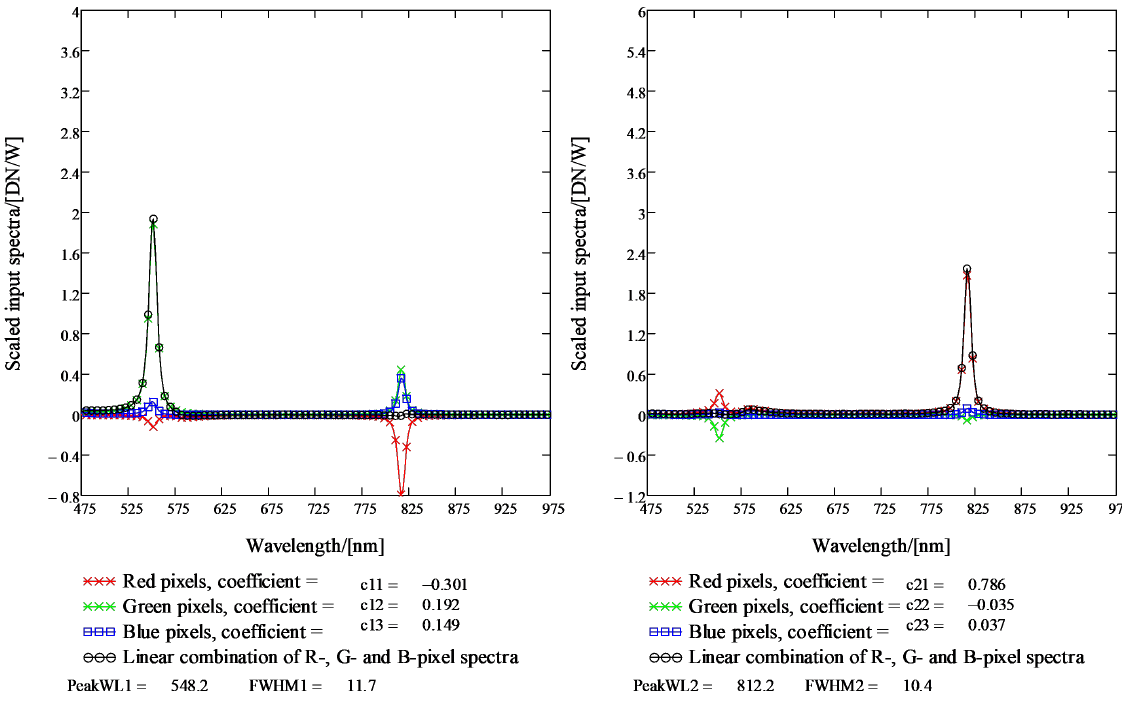
Figure 10. Results of the SICSURFIS HSI monochromator calibration. The linear combination of the scaled pixel sensitivity functions for the peak wavelengths 1, 2 and 3. For the selected PFPI drive voltage, there are two peak wavelengths, 548.2 nm (on the left) and 812.2 nm (at the